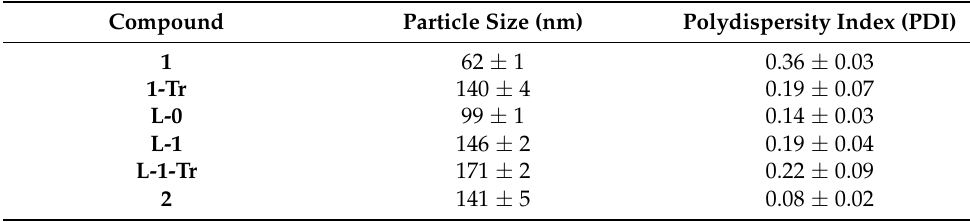
Table 1. Characterization of the vaccine